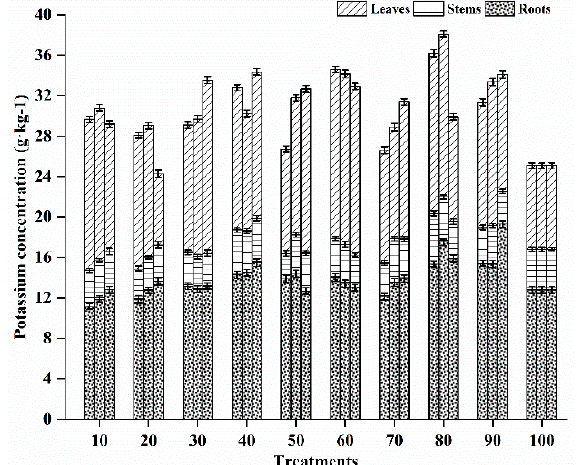
Figure 9. Potassium distribution in different vegetative tissues (Note: There are three linked bars: four fertilizer applications on the left, six fertilizer applications in the middle, and eight fertilizer applications on the right).